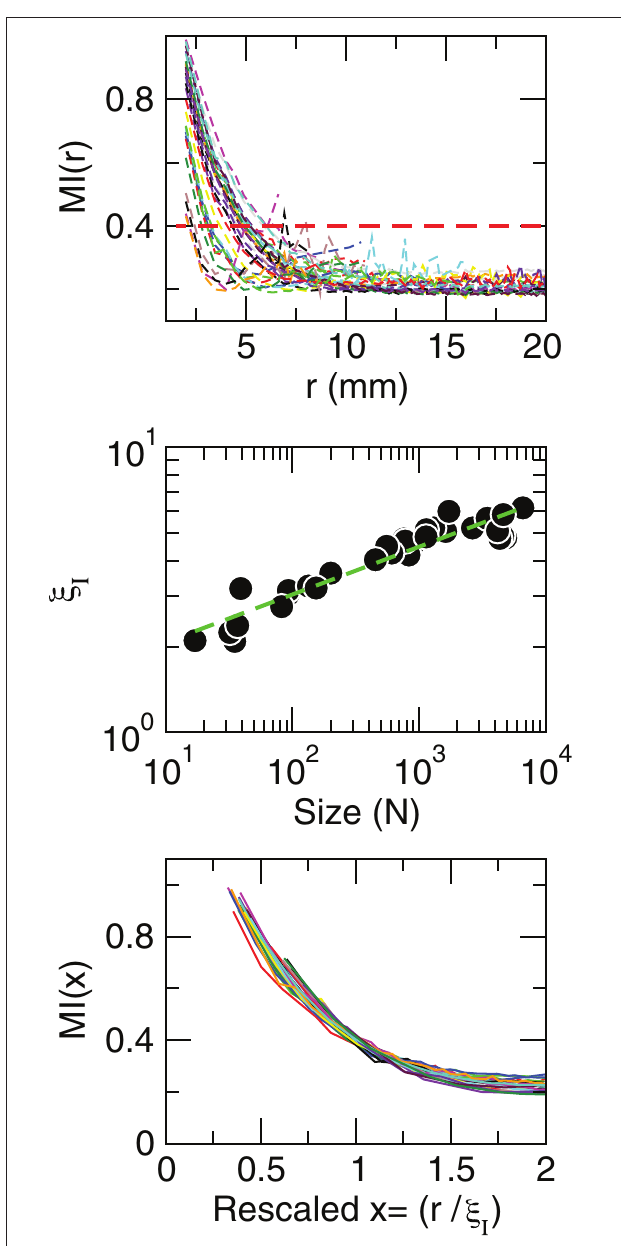
FIGURE 6 | Mutual information increases with cluster size. Each line in the top panel shows the mutual information MI ( r ) as a function of distance r averaged over all time series of each of the 35 clusters shown in Figure 1 . The length at which MI ( r ) decreased to a given value (red line in the top panel) denoted as ξ I , is an increasing function of the size of the cluster (middle panel). The bottom panel illustrates the good data collapse after rescaling the horizontal axis as x = r / ξ I